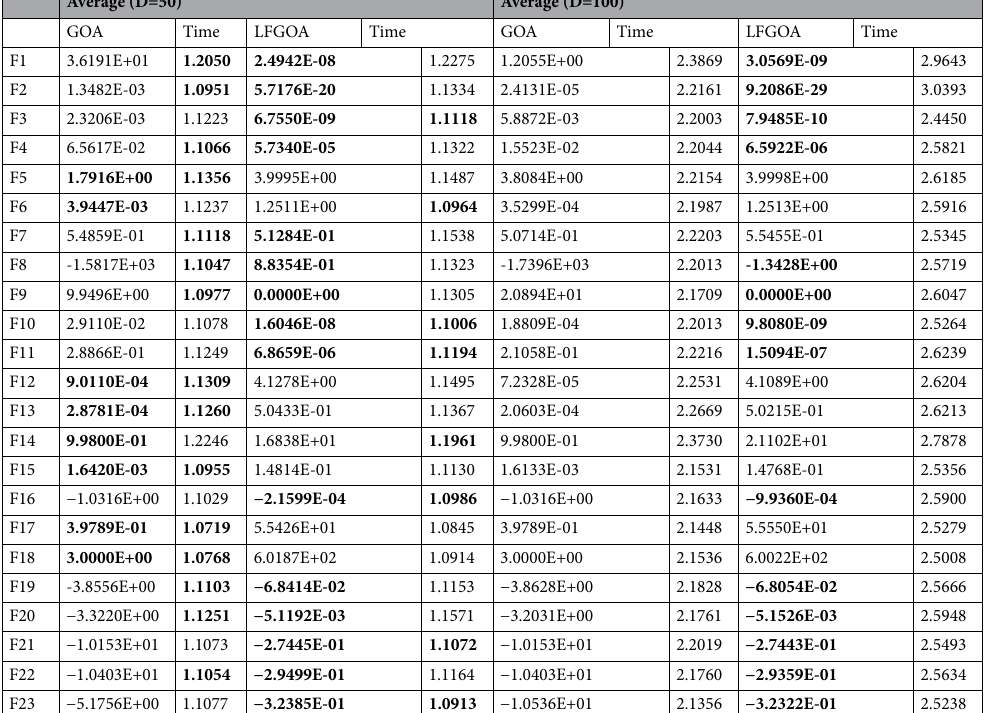
Table 9. The average values and consumed time under dimensions are equal to 50 and 100. The best of the comparison results are in [bold].